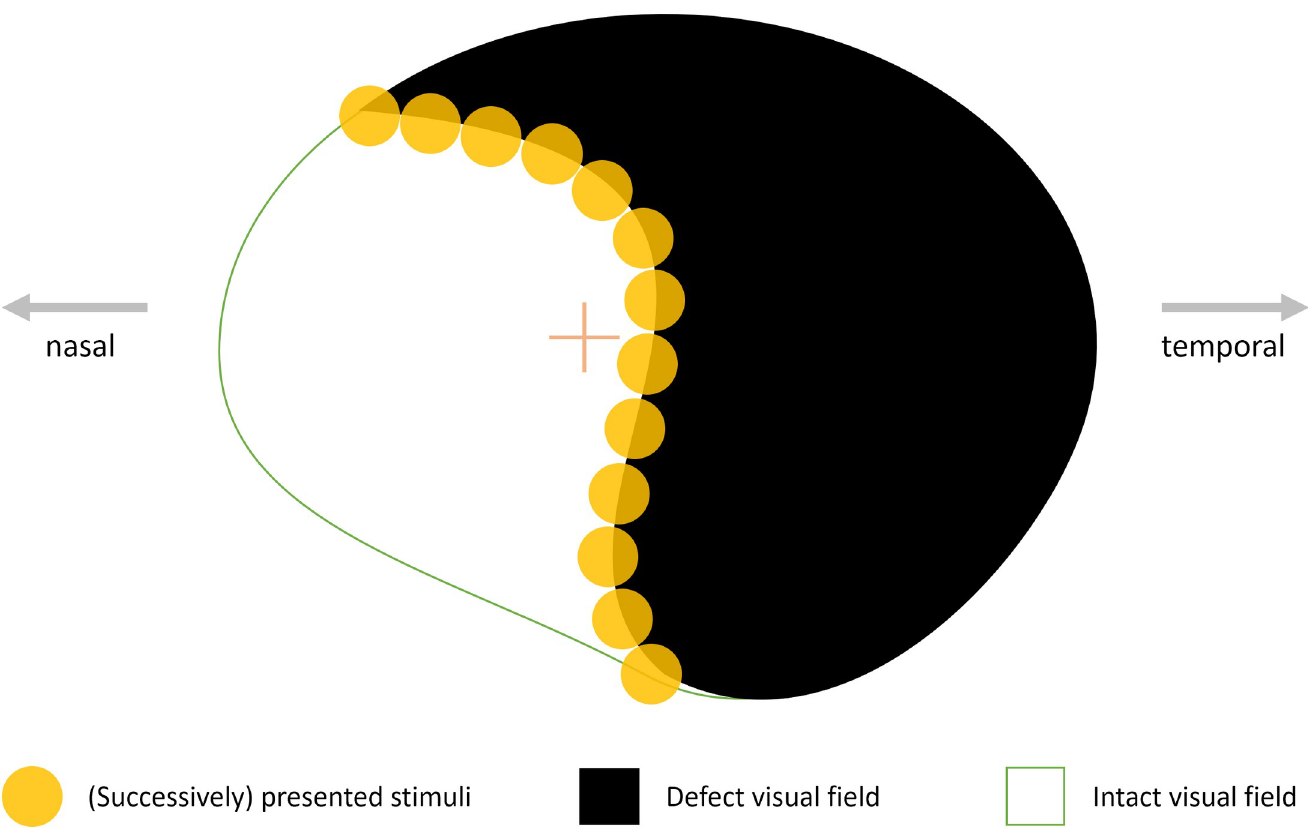
Fig 1. Exemplary illustration of the therapeutic principle of “Visual Restitution Therapies” (VRT). Bright light stimuli are presented randomly across the “border area”, which is between the patient’s defect and intact visual field. Proponents of this therapeutic approach argue that by repeating this process, damaged neurons— due to stroke or trauma—in early visual cortical areas reconnect over time, resulting in a diminished defect and enhanced visual field.